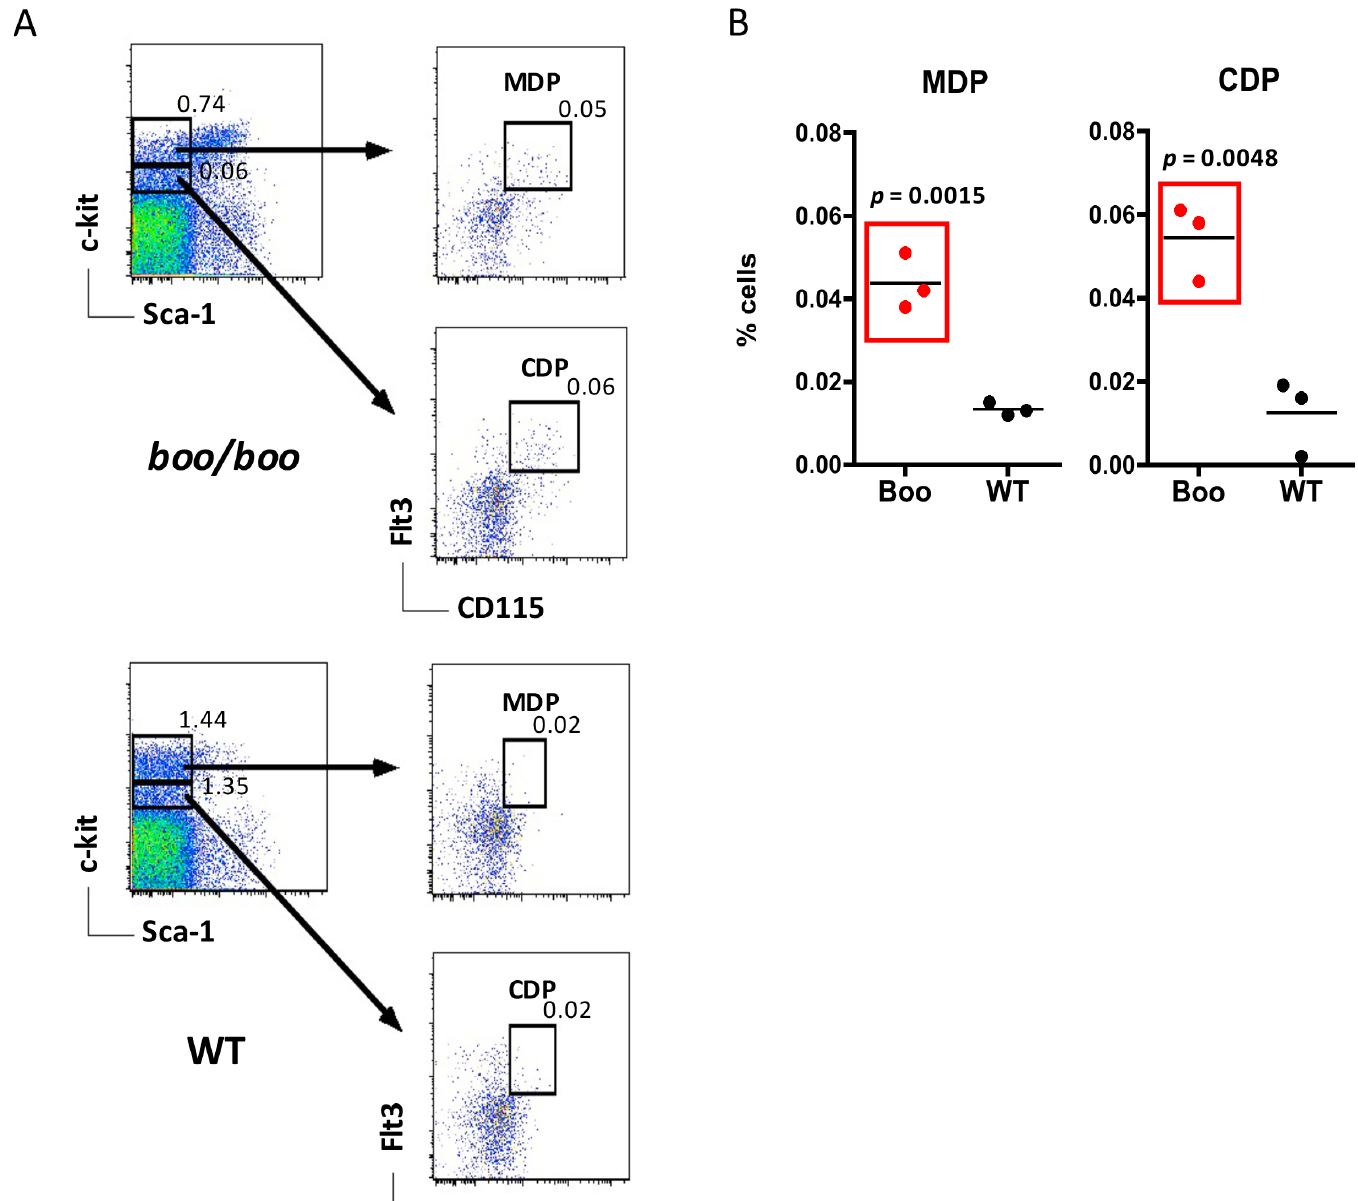
Fig 4. Booreana ( boo/boo ) mice have increasednumbers of dendritic cell progenitors in bone marrow. Cells from boo/boo and WT mice were preparedand stainedwith antibodiesto distinguish macrophage dendriticcell progenitors (MDP) and common dendriticcell progenitors (CDP) flow cytometrically. A lineagecocktail of antibodieswas used to gate the Lin - cells and so excludemature cells. Sca-1 and c-kit stainingwas used to identify the Lin - c-kit hi Sca-1 - and Lin - c-kit lo Sca-1 - subsets, and stainingfor Flt3 and CD115used to distinguish MDP and CDP amongst these subsets. Propidiumiodide (PI; 1 μ g/ml) stainingwas used to gate live cells (PI - ). Gates were set on bivariateplots using isotype control antibodies, and numbers in gates reflect % positive cells amongst Lin - PI - bone marrow cells. (A) Profiles for representative individualmice are shown. (B) Percent cells amongst viableLin - bone marrow is shown for 3 individualmice, with mean value shownas a bar, and statistically significantresults (p (cid:20) 0.05) boxed in red.